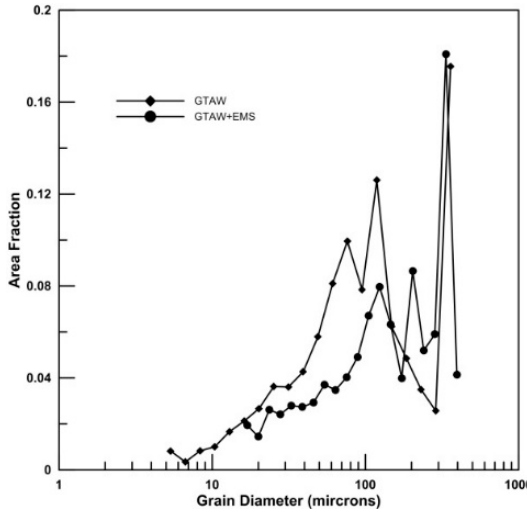
Figure 10. The relationship between the area fraction and grain-diameter group for the welds.